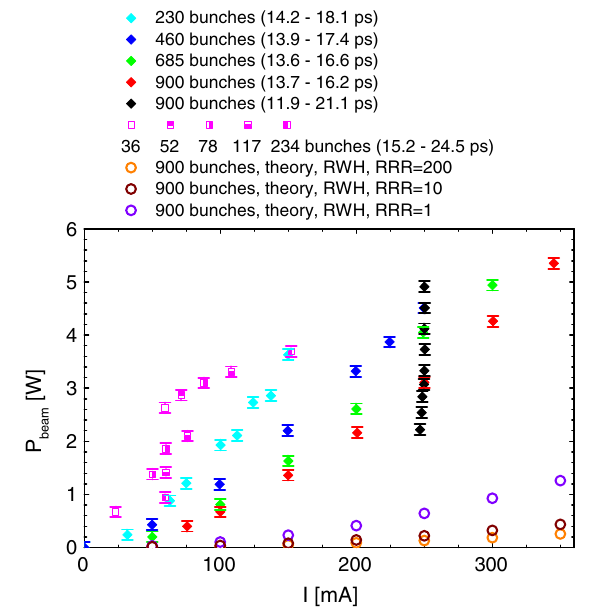
TABLE I. Machine parameters of the Diamond Light Source [7]. FIG. 1. Beam heat load as a function of the average beam current for a wide range of beam parameters. Included are measurements for four beam current ramps with a certain number of bunches in one train (cyan, blue, green, red), beam current steps for filling patterns with equally distributed bunches (ma- genta) and a measurement with everything fixed except the bunch length (black). The circles show the expected beam heat load from resistive wall heating for three different purities of